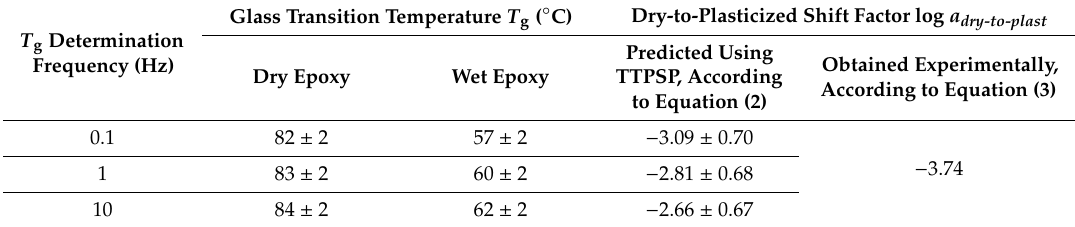
Table 2. Experimentally determined T g values and best TTPSP shift factors